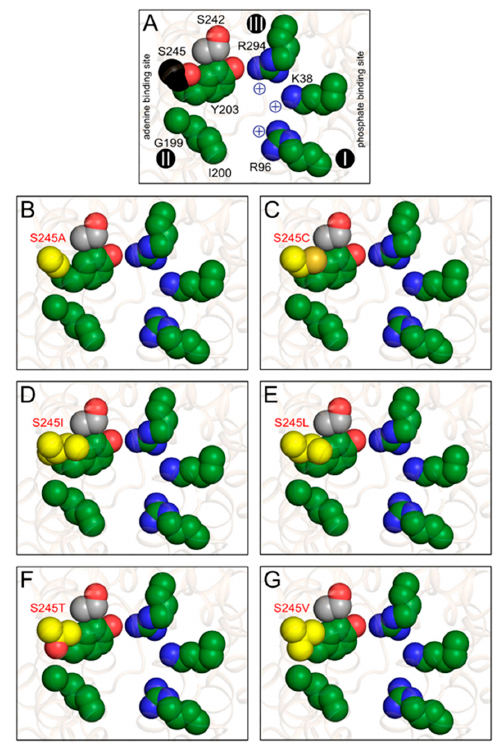
Figure 9. S245 substitutions change the properties of the putative substrate binding pocket . ( A ) Consensus substrate binding site of the yeast ADP/ATP carrier ScAac2p (PDB entry 4c9g) based on computational analysis [16,17,28,37]. The putative adenine binding site (G199, I200, and Y203) and positively charged residues (K38, R96, and R294) involved in binding of the phosphate moieties of the nucleotides are shown in green, whereas S242 and S245, which are close to this site, are shown in grey and black, respectively. The contact points I, II, an III on transmembrane helices H2, H4, and H6, respectively, are also indicated as black spheres with roman numerals [33,34]. Putative substrate binding site in ( A ) wild-type; ( B ) S245A; ( C ) S245C; ( D ) S245I; ( E ) S245L; ( F ) S245T; and ( G ) S245V with the substitutions, shown in